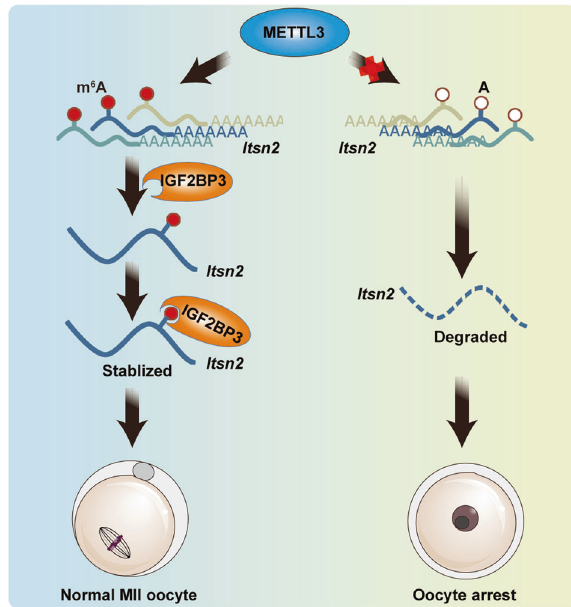
Fig. 7 Schematic model for the regulatory landscape of the METTL3/IGF2BP3-m 6 A- Itsn2 signaling axis in the promotion of oocyte development. In WT mouse oocytes, Itsn2 mRNA with m 6 A could be recognized by IGF2BP3 to furtherly enhance its stability and promote oocyte meiotic maturation. However, in Mettl3 Gdf9 cKO mouse oocytes, Itsn2 mRNA without m 6 A could be degraded after losing IGF2BP3 protection, leading to oocyte meiotic maturation